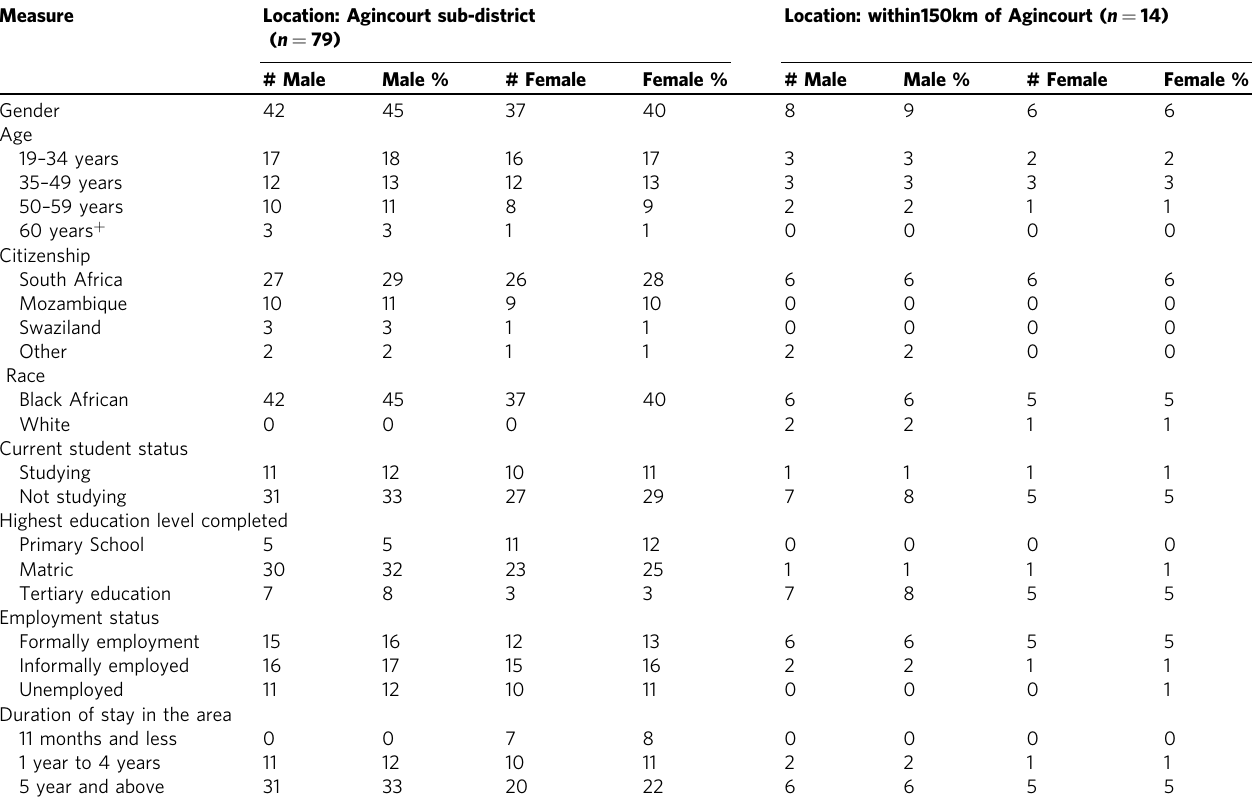
Location: within150km of Agincourt ( n =